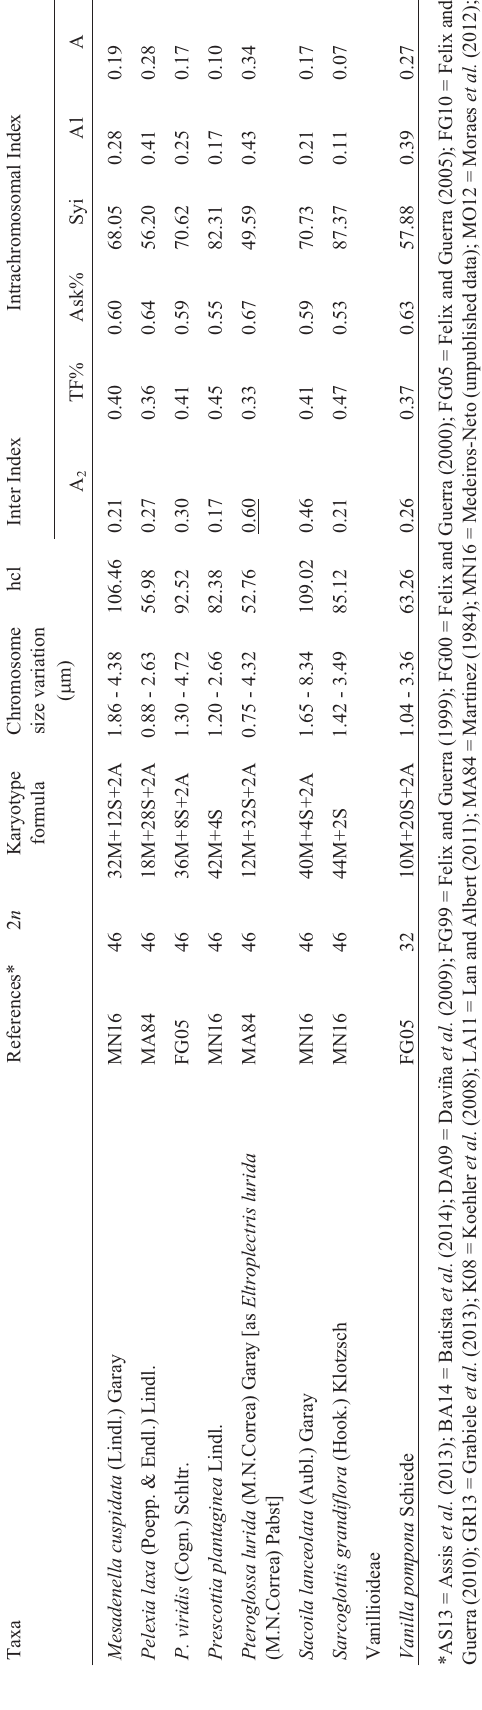
Figure 1 - Interchromosomal index A2 values for Orchidaceae subfamily. For each subfamily the mean value (dot), the amplitude of variation (bar), thenumberofspeciesanalyzedandmodevalue(lasttwodataintheparen- thesis, respectively) are